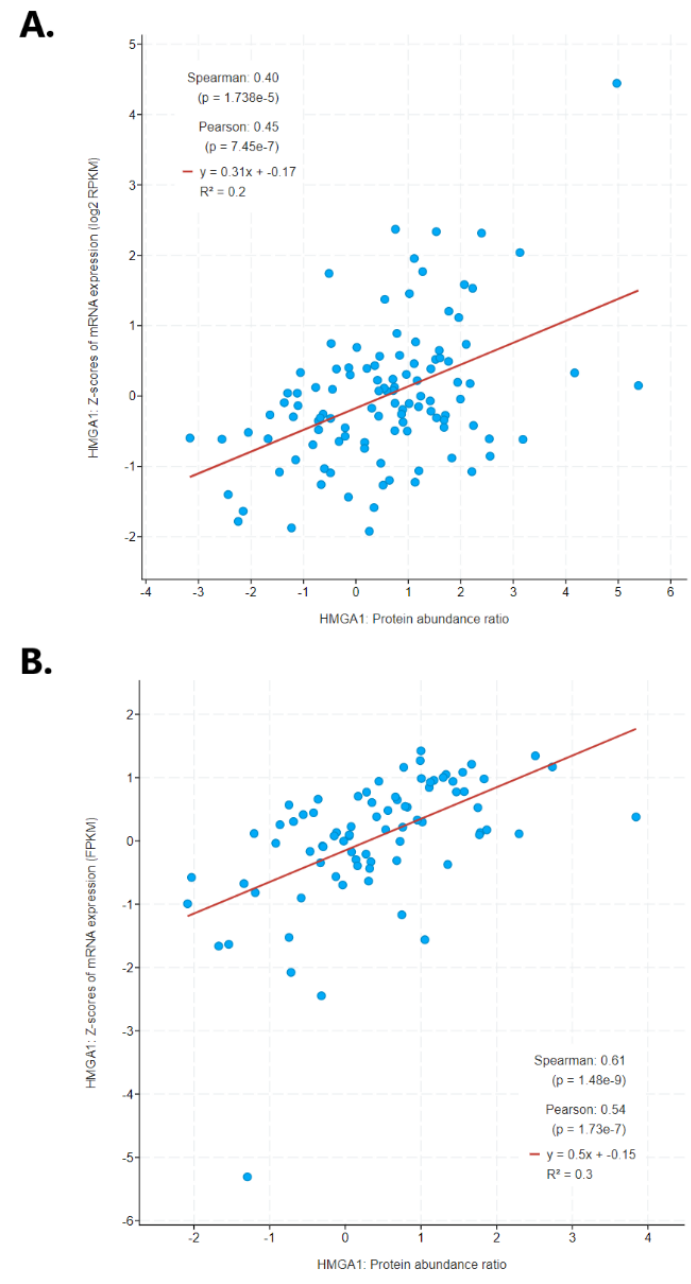
Figure 7. Correlation between the HMGA1 mRNA expression level and HMGA1 amount ratio in ( A ) lung adenocarcinoma and ( B ) lung squamous cell carcinoma, calculated using cBioPortal. 2.4. HMGA1 Expression Level in Lung Cancer Could Be Connected with Methylation Status but Not with DNA Alterations of the HMGA1 Gene HMGA1 overexpression observed at the mRNA level is a common feature of lung cancer. One of the reasons for this may be changes in the sequence or the copy number of the HMGA1 gene. Therefore, Oncoprint was generated by using cBioPortal to query 7276 patients/7799 samples from 27 studies (Figure 8A). It revealed that HMGA1 gene altera- tions were stated in only 1.1% of lung cancer patients profiled for copy number changes, mutations, and structural variants of the gene, namely in about 1.5% of lung adenocarci- noma and 0.5% of lung squamous cell carcinoma cases. Among them, the most frequently detected were gene amplification, with deep deletions less frequently (Figure 8B). The only mutation reported was the T75S missense mutation in lung adenocarcinoma (Figure 8C). The data from Oncomine confirmed no substantial change in copy number variation of HMGA1 across different lung cancer subtypes (Figure 9). However, plotting HMGA1 expression level against copy number alterations clearly showed an increase in the level from deep deletion to amplification (Figure 10A). A statistically significant positive corre- lation was noted between HMGA1 expression level and log2 copy-number value (R Spear- man 0.24, p < 0.001; R Pearson 0.28, p < 0.001; Figure 10B).